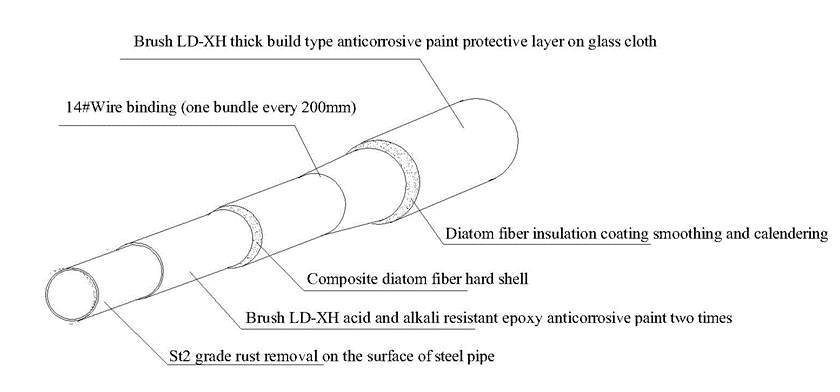
Fig. 2 Schematic diagram of the composite insulation structure made of diatom shell and diatom